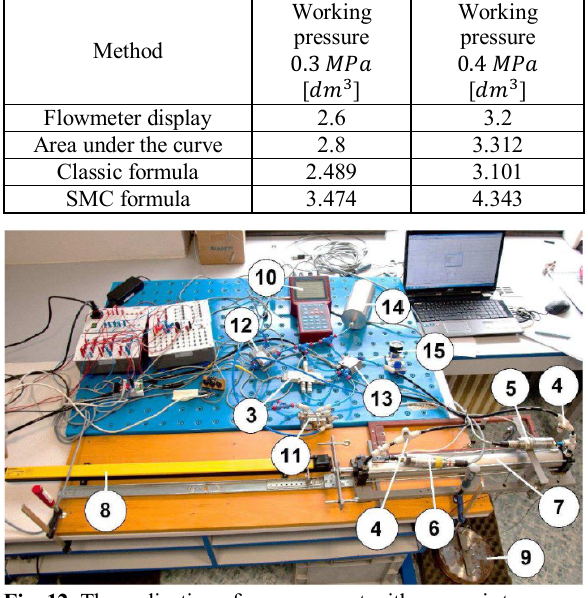
Fig. 15. Graph of consumption of compressed air for working pressure 0.3